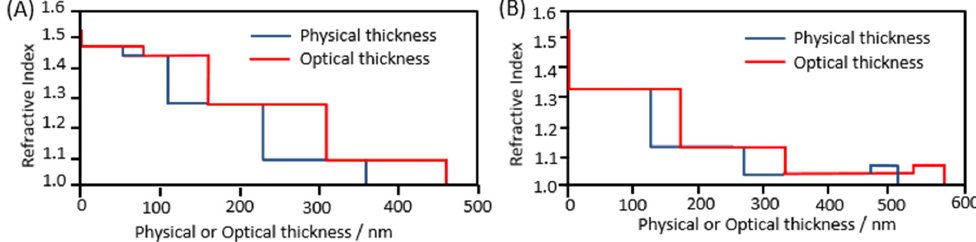
Figure 2. Two designs generated by G.A optimiz for 0° angle incidence ( A ), and 0–80° angle incidence ( B ). The first design follows a conventional index profile, while the second design has a thick low index third layer and a higher index fourth layer.